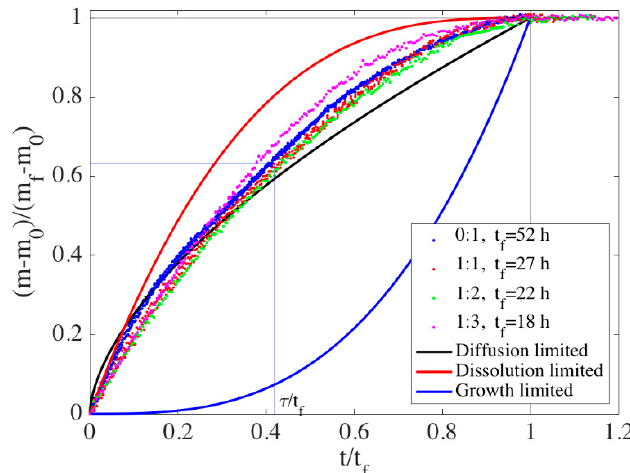
Figure 3. Mass evolution with normalized time for four different CaCO 3 cement compositions. The solid line shows the predicted evolution from models with diffusion, vaterite dissolution and calcite growth as the rate-limiting steps.